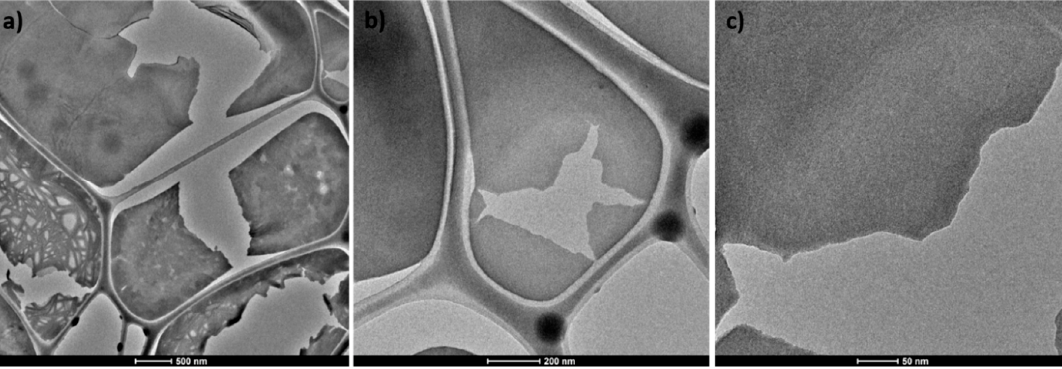
Figure 3. ( a – c ) TEM images of hydrated and non-crystalline WO 3 − x . at various magnifications.